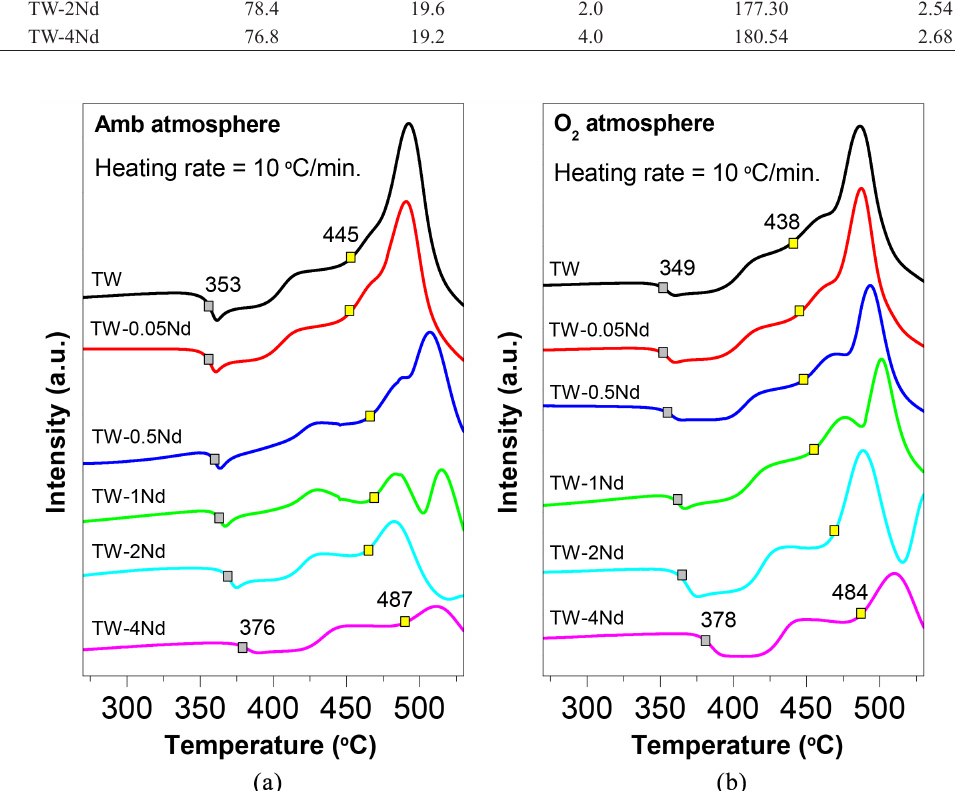
Figure 1. DTA curves of the undoped and Nd 3+ - doped TW glasses prepared in: (a) Amb and (b) O